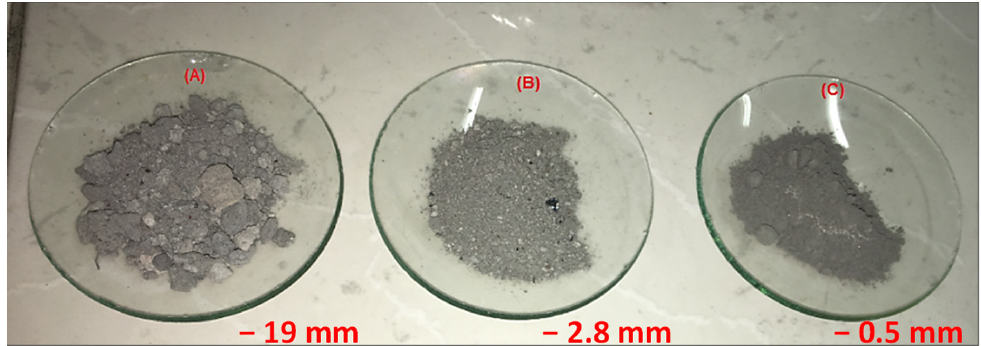
Figure 1. Salt slag aliquots produced after initial preparation.